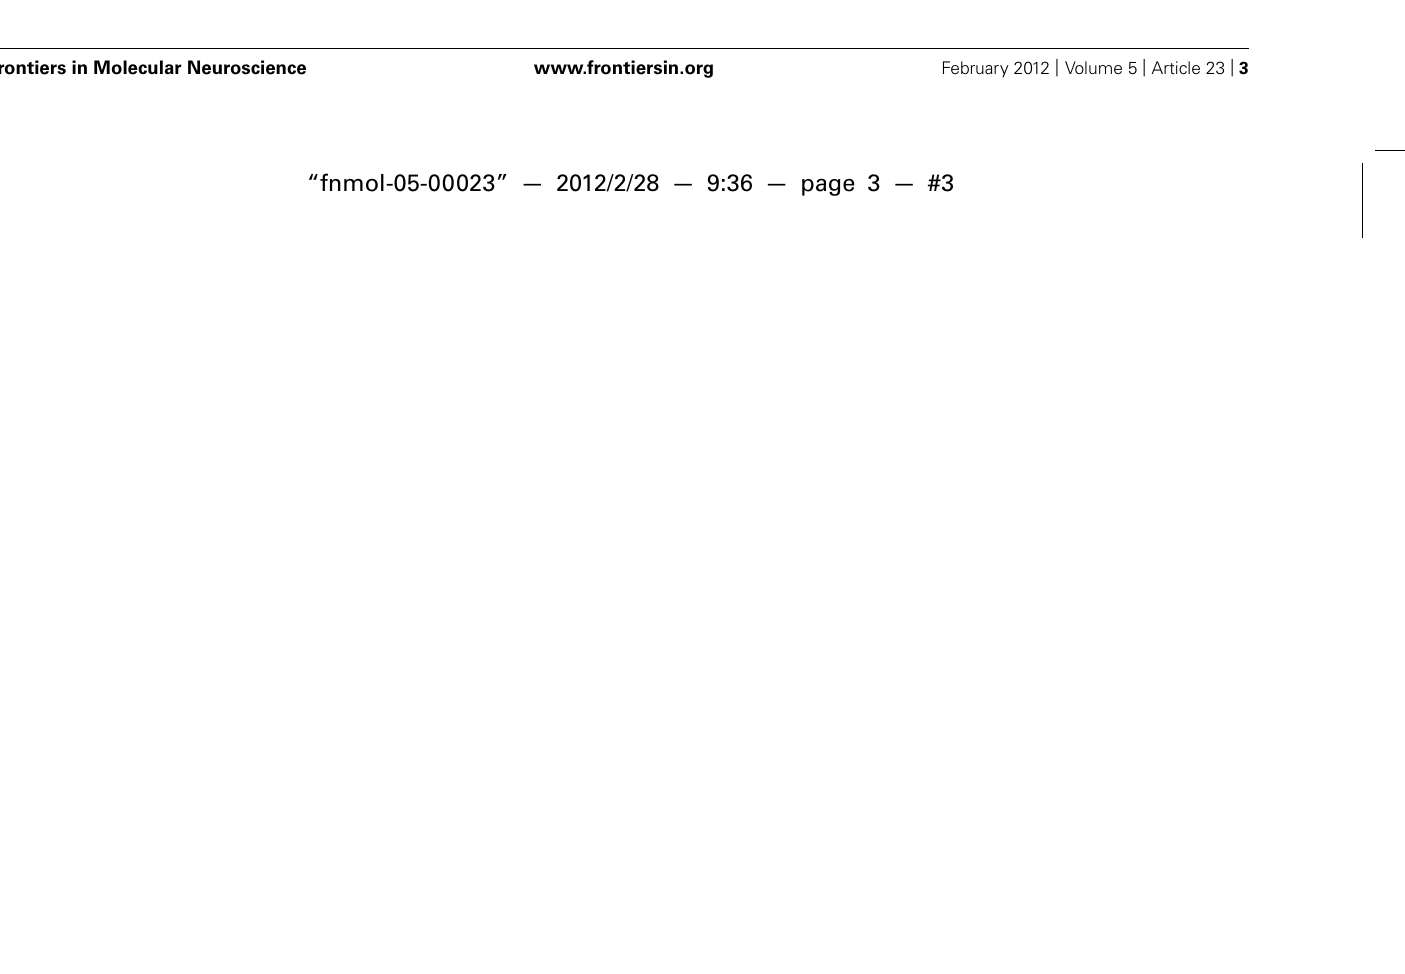
FIGURE 2 | Molecular components of the core clock. Light stimulates glutamatergic synaptic activation via the retinohypothalamic tract on NMDA receptors within the mammalian SCN, to generate signaling cascades which are mediated by various plasticity-related proteins.The cascade can reset the transcriptional/translational autoregulatory feedback loop to